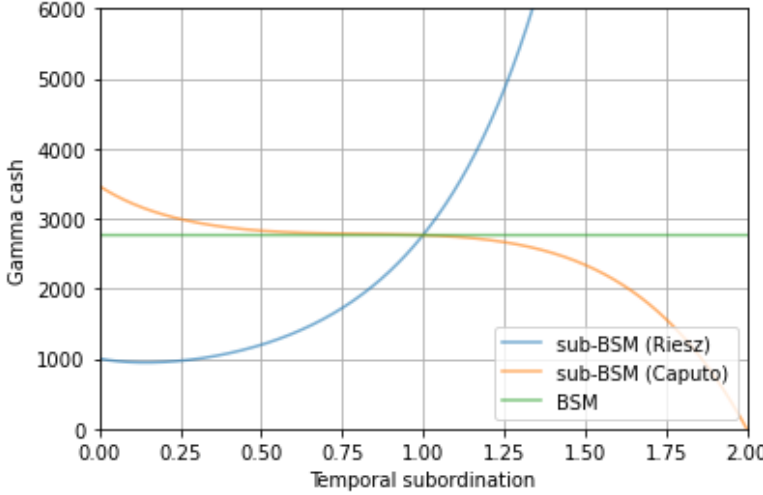
Figure 2. Gamma cash in the 2 subordinated BSM models (Riesz or Caputo fractional derivative) vs. Gamma cash in the BSM model. Parameters: K = 4000, r = 2%, q = 1%, σ = 0.2, and τ =